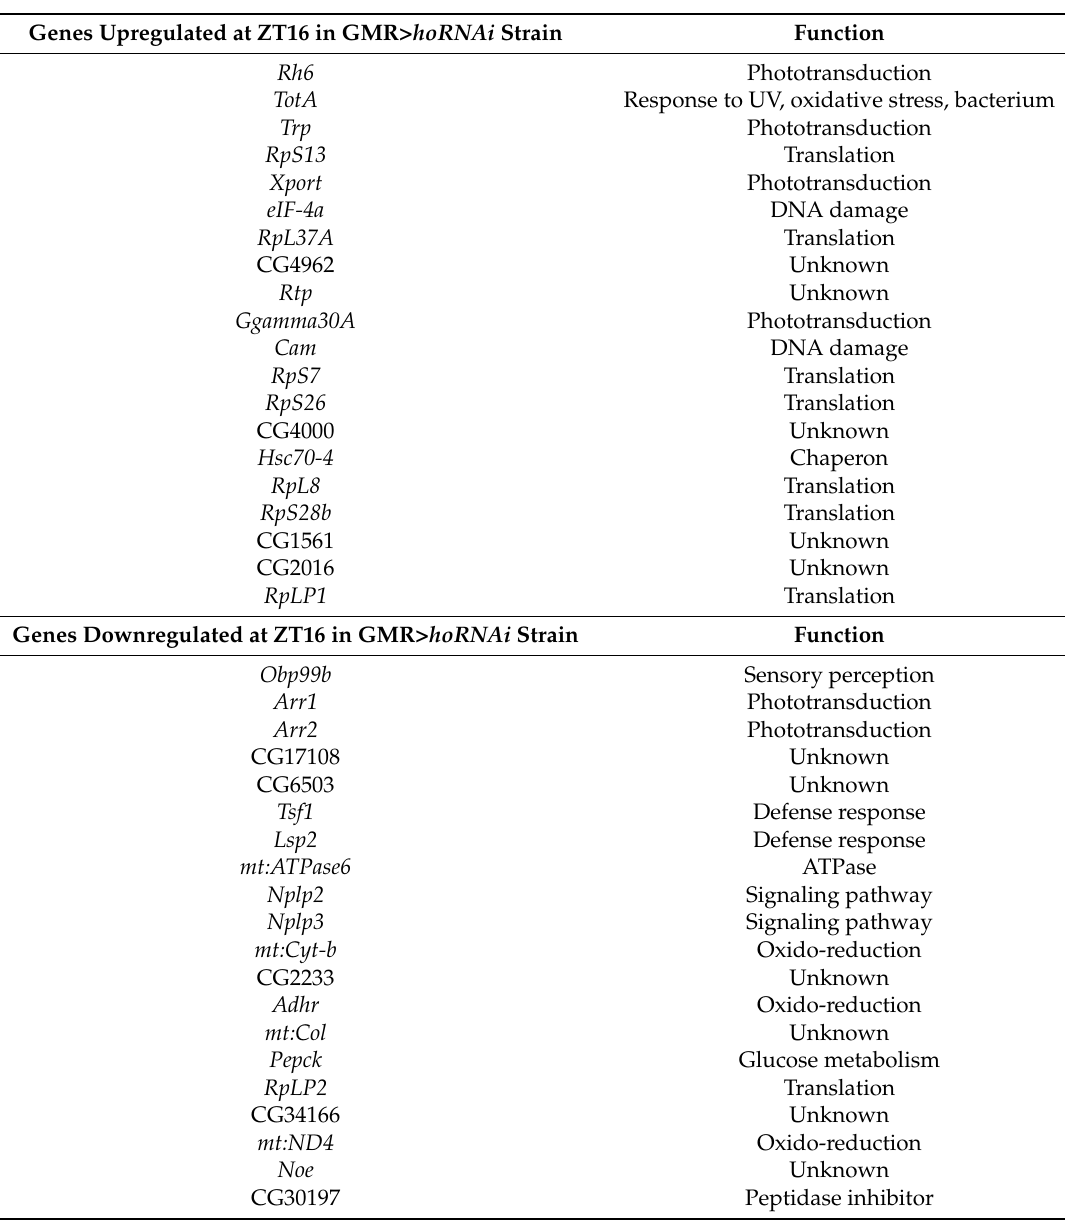
Table 6. Top 20 genes up- and downregulated after ho silencing in photoreceptor cells at